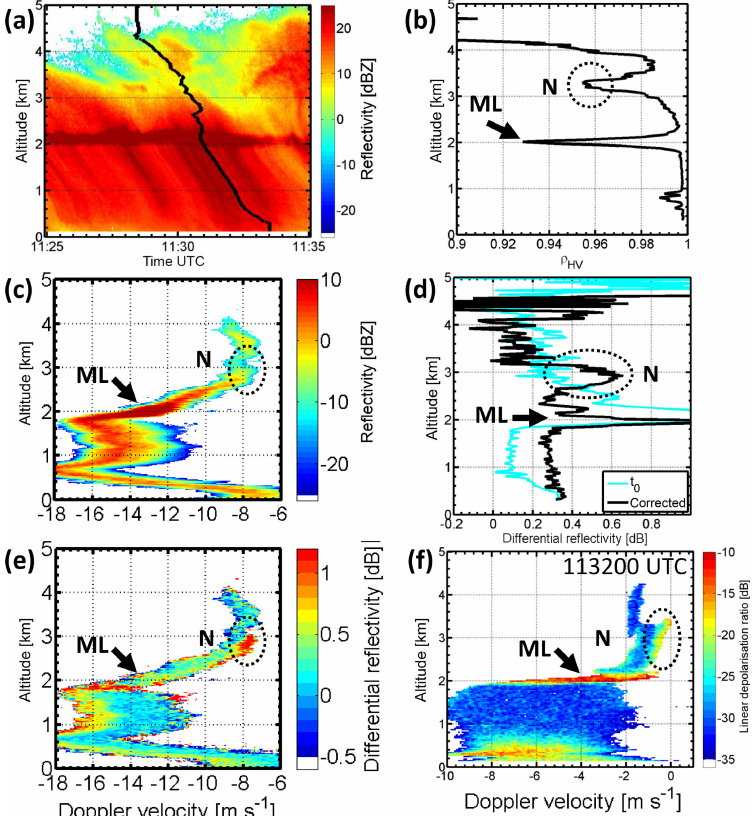
Figure 10. Panel (a) shows the retrieved fall streak at 11:33:31UTC on top of the Z field. Panels (c, e) are the fall streak corrected spec- trograms ( sZ and sZ DR , 45 ◦ elevation – note that the Doppler velocity contains the radial wind). Panels (b, d) show the fall streak corrected profiles of ρ HV and Z DR in black, while light blue represents the vertical Z DR profile at 11:33:31UTC. Panel (f) shows the sL DR spectro- gram of the vertical pointing Mira at 11:32:00UTC (all data displayed in the spectrograms have SNR > 10dB). ML points out the signature of the melting layer and N the signature related to the new particle